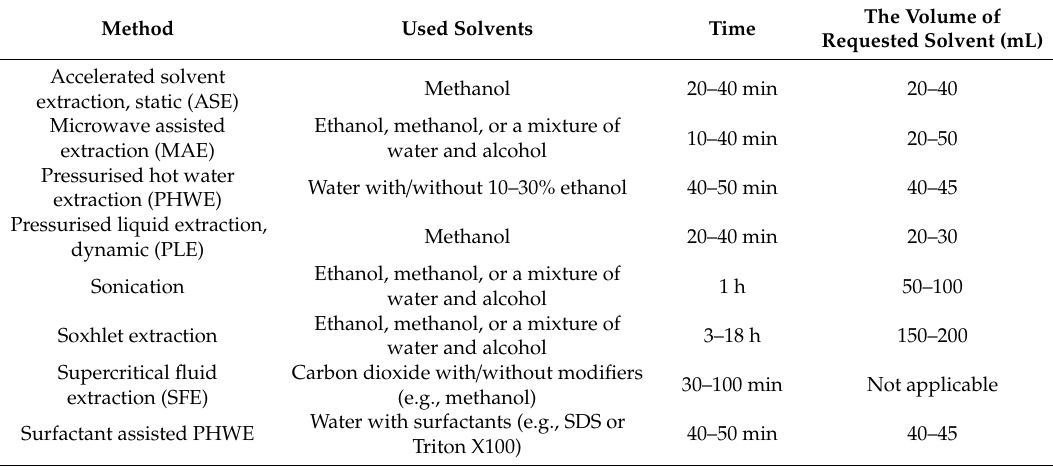
Table 1. Analytical methods for the extraction of the main molecules in foodstu ff s